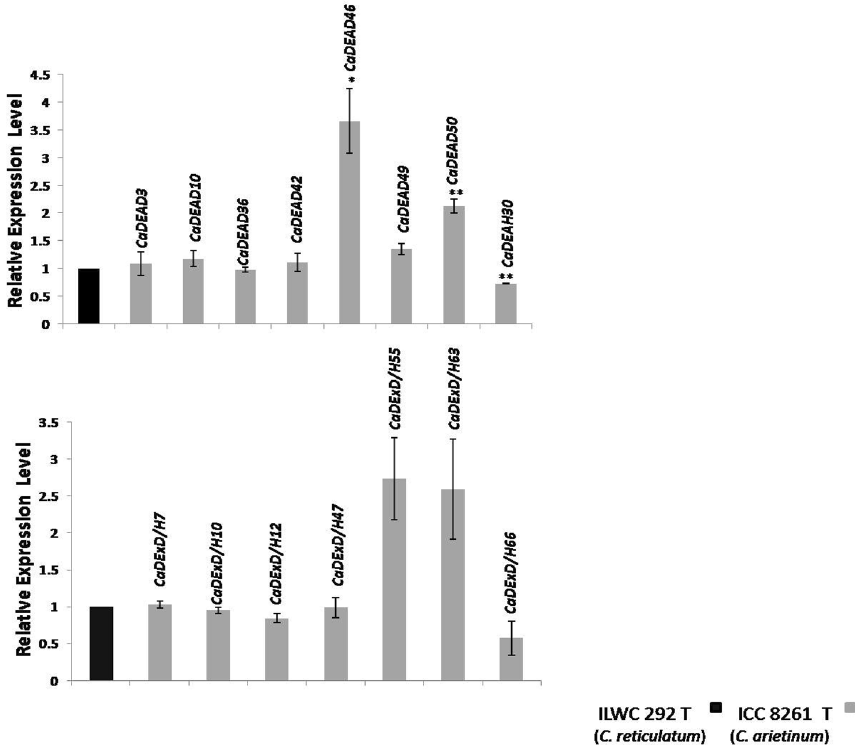
Figure 12. The relative expression levels of selected 15 RNA helicase genes (7 CaDEAD , 1 CaDEAH and 7 CaDExD/H -box genes) in leaf tissues of two genotypes, ILWC 292 ( C. reticulatum ) and ICC 8261 ( C. arietinum ), in response to drought stress (T24), as estimated by qRT-PCR. The T24 treatment indicates water being withheld for 24 days beginning with 93 DAS. The relative expression levels which were normalized to GAPDH were determined by the comparative CT method (2 − ΔΔCT). The expression level of genes for ILWC 292 T24 was considered as control (expression = 1). Three biological and technical replicates were used for each experiment. Error bars indicate standard errors of means. The *symbol above bars indicates significant difference at p < 0.05 and **indicates significant difference at p <